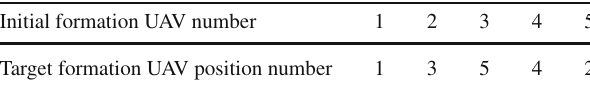
Table 2 A set of target assignment Initial formation UAV